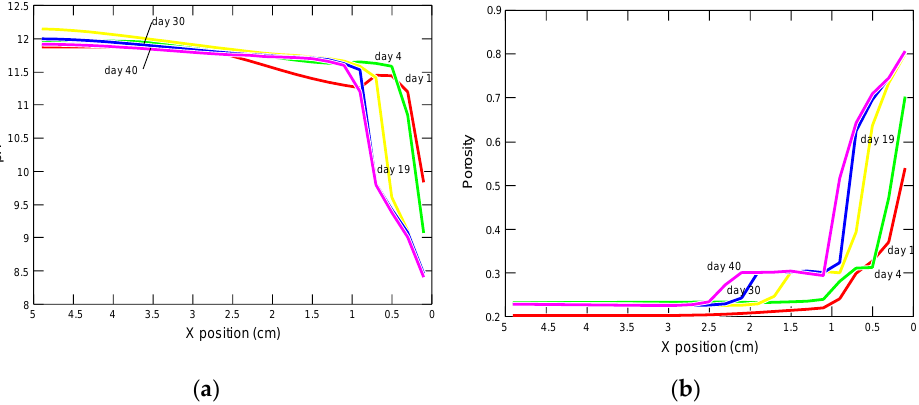
Figure 17. Profiles of changes in ( a ) pH and ( b ) porosity in the model domain after 1, 4, 19, 30 and 40 days from the beginning of the experiment.